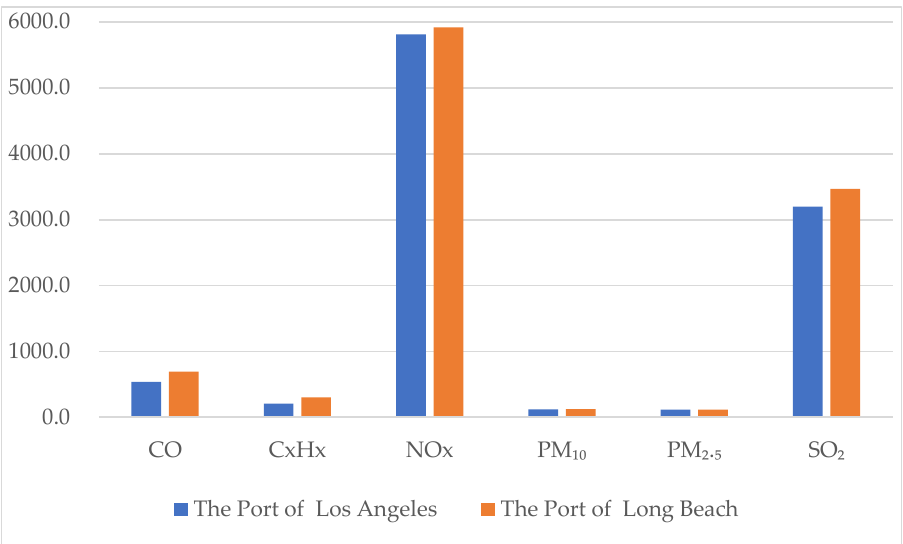
Figure 8. Comparison of various pollutant emissions in different ports (unit: ton).